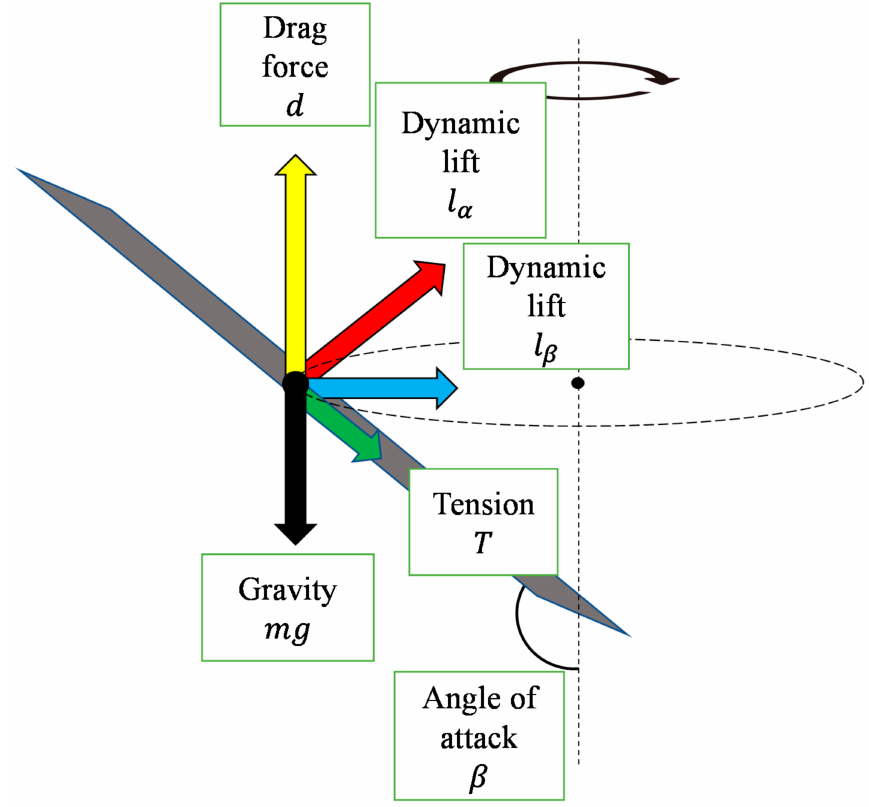
Figure 10. Rotational motion of a single